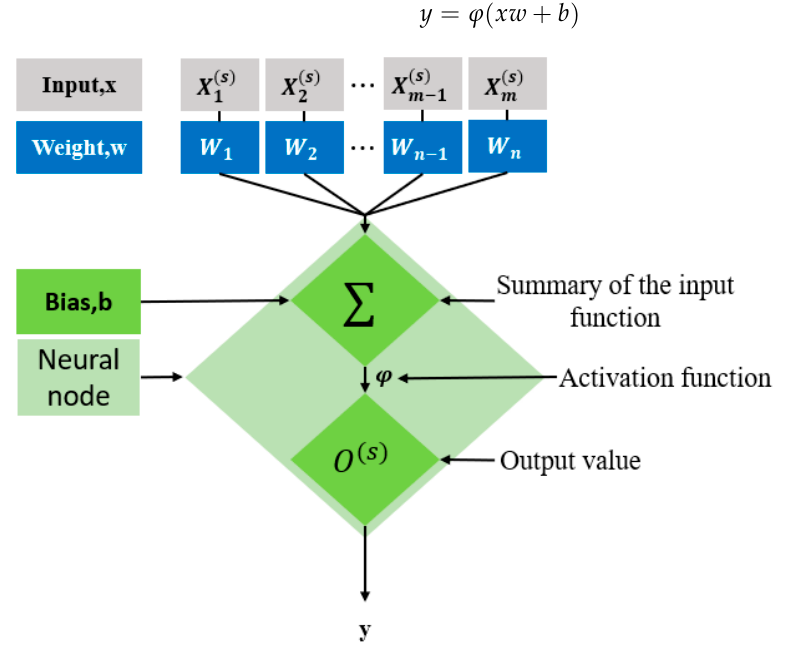
Figure 2. Single-neuron perceptron model.